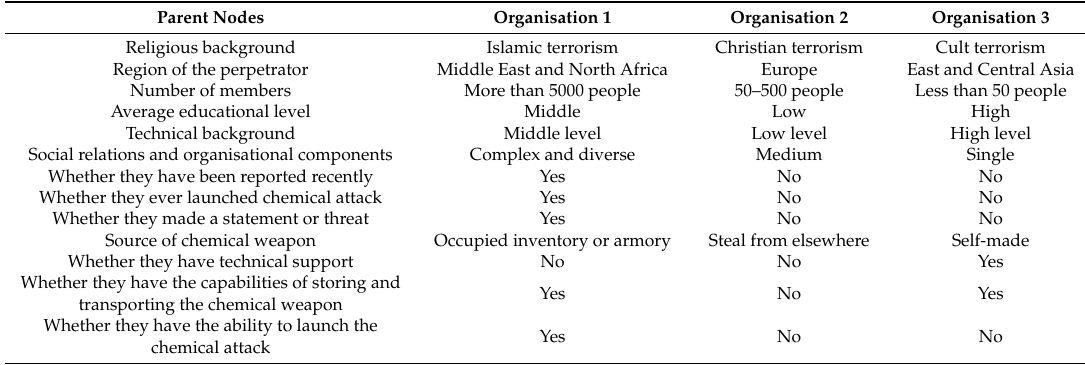
Table 8. Bayesian network node status of three terrorist organisations. Parent